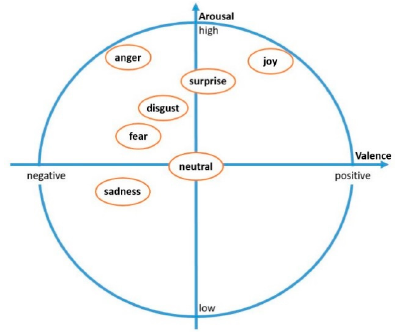
Figure 1. Representation of seven basic emotions in the arousal-valence dimension.